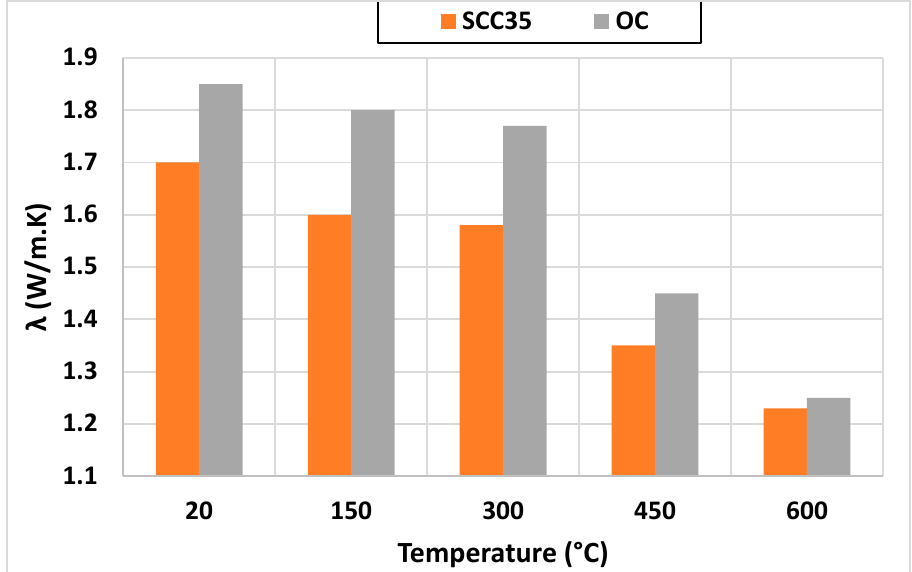
Figure 12. Effect ofthe heating-cooling cycle on the thermal conductivity.